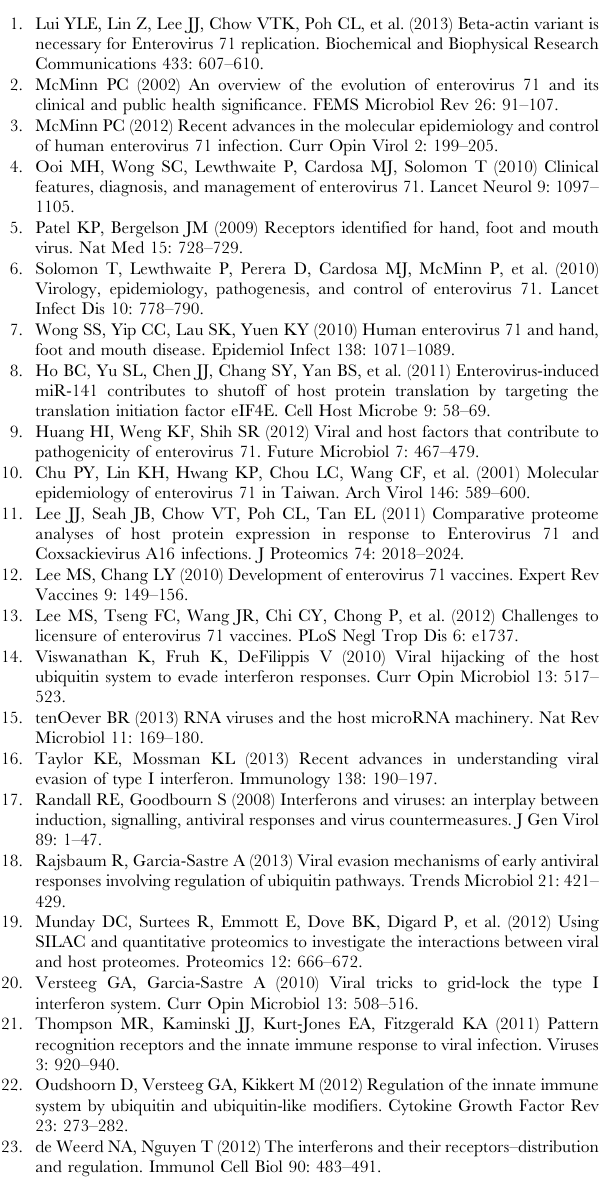
Table S1 Altered miRNA expression profile of EV71 infected and non-infected control colorectal cells,